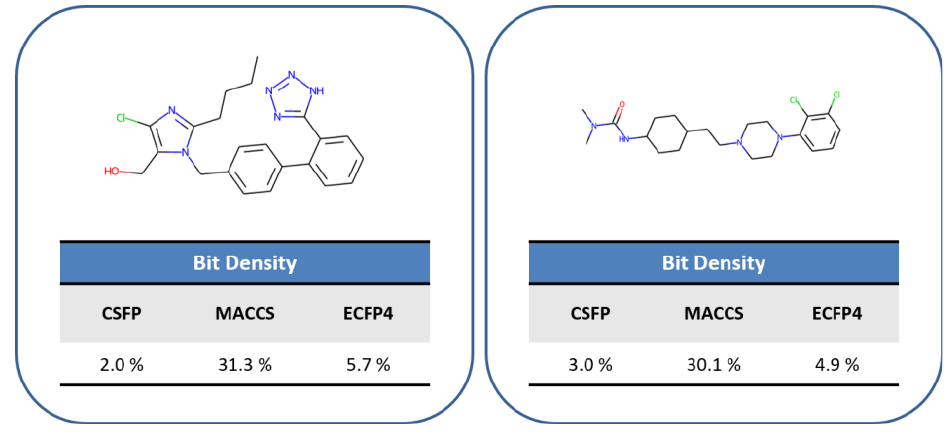
Figure 3. Distribution of FP features. Boxplots show the distribution of features (bits set on) for MACCS (blue), CSFP (gold), and ECFP4 (green) and a random sample of 1000 compounds from all activity classes. In boxplots, the upper and lower whiskers indicate maximum and minimum values, the boundaries of the box represent the upper and lower quartiles, values classified as statistical outliers are shown as diamonds, and the median value is indicated by a horizontal line.